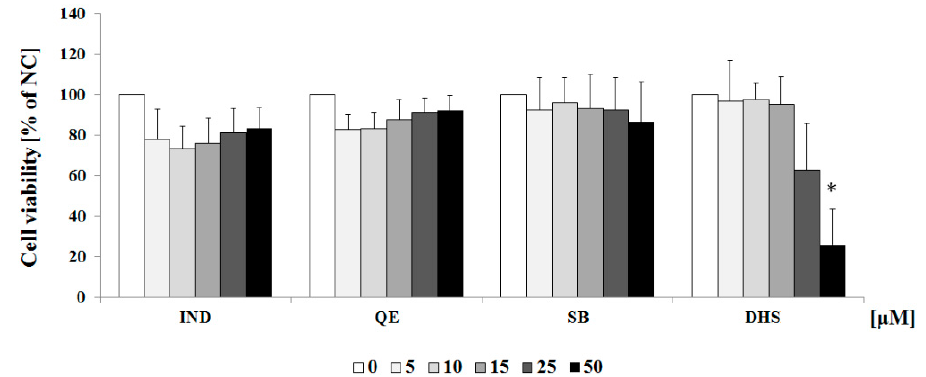
Figure 1. Cytotoxicity of QE, SB, DHS and IND on NHDF following direct 24 h exposure to flavonoids at different concentrations. Data are presented as the percentage cell viability relative to the control group NC (set to 100%) and represented as mean ± SEM ( n = 3). Significant cytotoxicity was indicated as * p < 0.05 vs. control cells (0.1% vehicle DMSO in serum-free culture medium). NC: negative control (0.1% vehicle DMSO in serum-free culture medium).